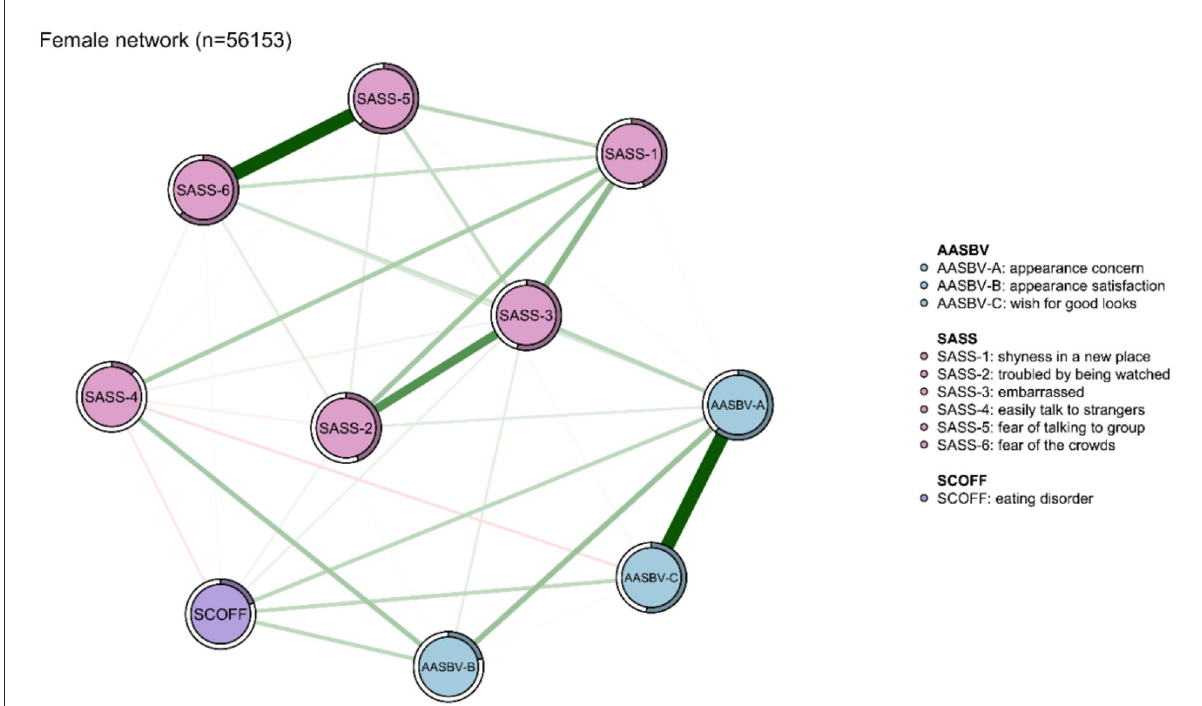
FIGURE3 Network analysis between symptoms of eating disorder, appearance anxiety, and social anxiety in the female sample ( n = 56,153). The thickness of the edges indicates the magnitude of the association. Green edges referred to positive associations, while red edges showed negative ones. The circle around the item represents the amount of